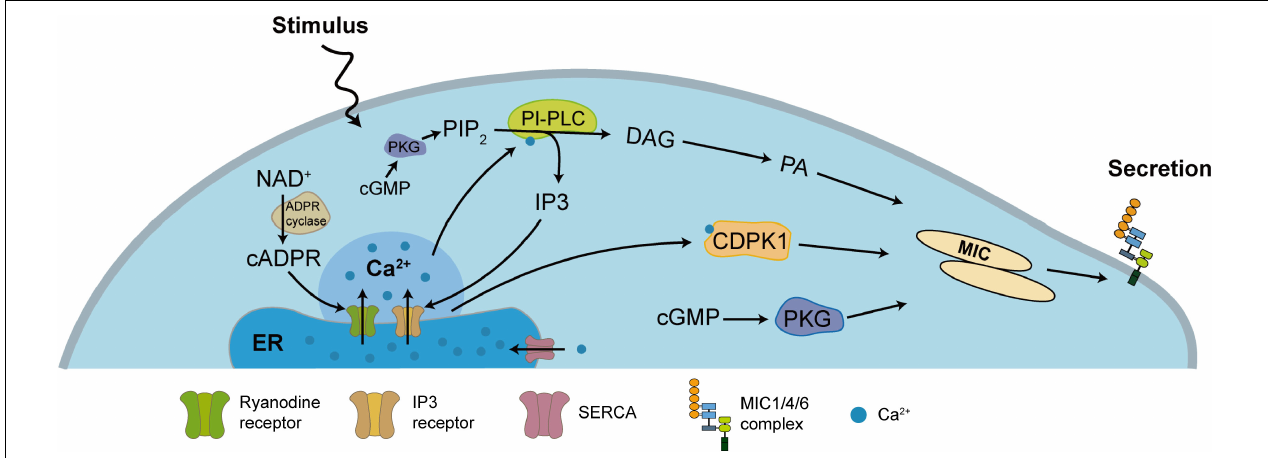
FIGURE 2 | Ca 2 + -dependent secretory regulation pathway of TgMIC1/4/6. Most of Ca 2 + in T. gondii are stored in the ER and produce a series of signaling cascades after stimulation. PIP 2 generates IP3 and DAG through PLC, or NAD + generates cADP-ribose through ADP ribosyl cyclase, and releases Ca 2 + into the cytoplasm by the action of the Ca 2 + channel on the ER membrane, which further converts DAG into phosphatidic acid (PA), and also activates CDPK1 to stimulate MICs secretion. Independently, activation of cGMP can activate PKG, which is also important for controlling MICs secretion. Other studies in the malaria parasite indicate that cGMP and PKG also indirectly control the synthesis of PIP 2 . On the other hand, SERCA pumps Ca 2 + back into the lumen of the ER to restore the level of Ca 2 + in the ER and